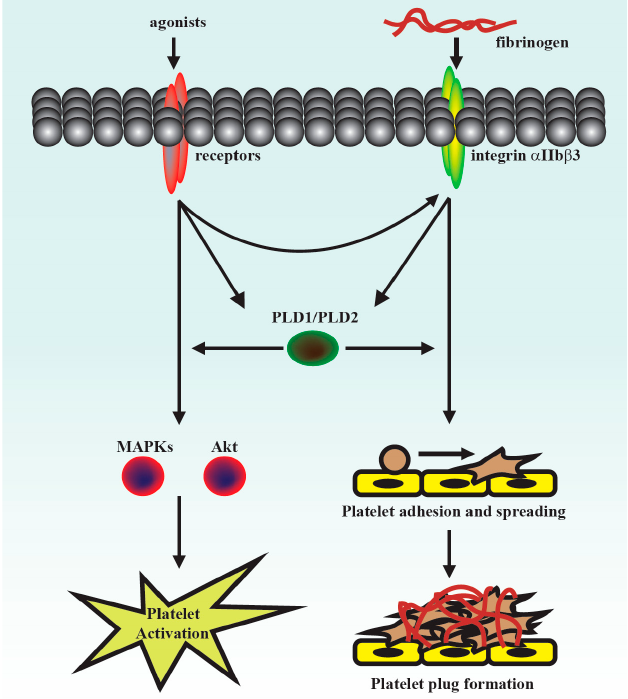
Figure 6. Hypothetical scheme of PLD (PLD1 and PLD2) involvement in human platelet activation. PLD may be involved in the activation of Akt and MAPK, leading to granule release and subsequent inside-out signaling-mediated integrin α IIb β 3 activation. It may also be involved in outside-in signaling of integrin α IIb β 3 and support platelet adhesion, spreading, and plug formation, thus stabilizing thrombus formation.